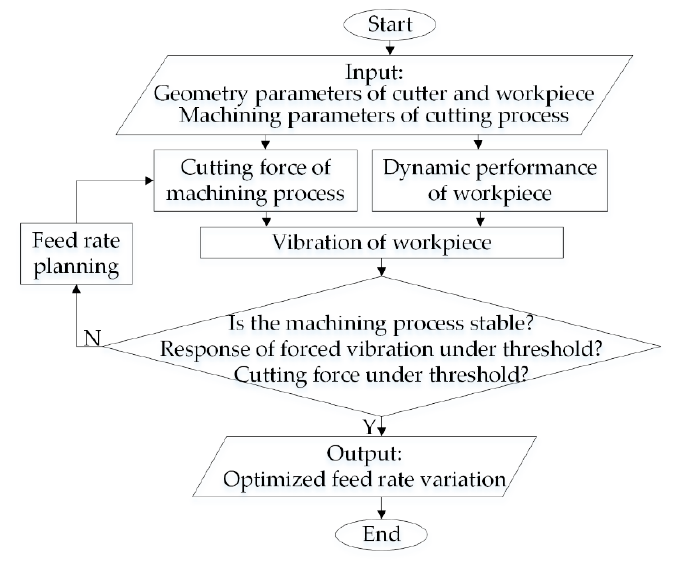
Figure 1. General flow diagram of the proposed feed rate variation strategy.